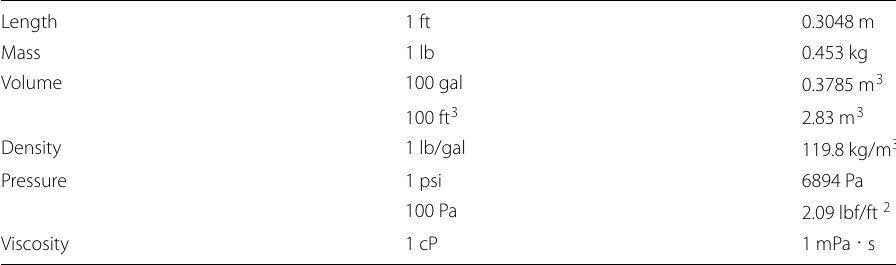
Table 6 Conversion table from field unit to SI unit